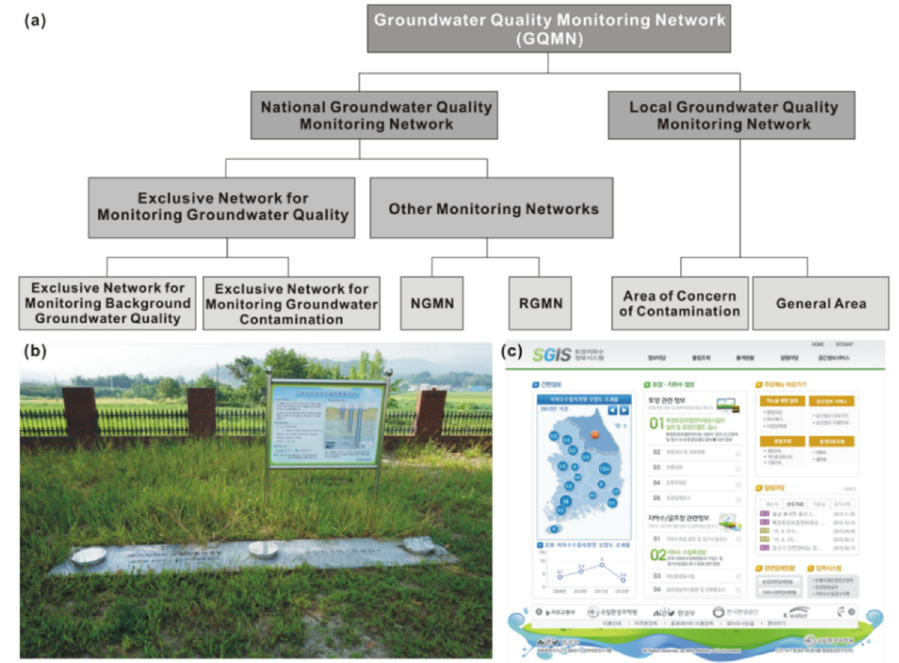
Figure 4. ( a ) Structure of the Groundwater Quality Monitoring Network (GQMN) of Korea; ( b ) location of the exclusive monitoring wells with different depths (18, 36, 80 m); and ( c ) webpage screenshot (sgis.nier.go.kr) showing the monitoring results for groundwater quality.